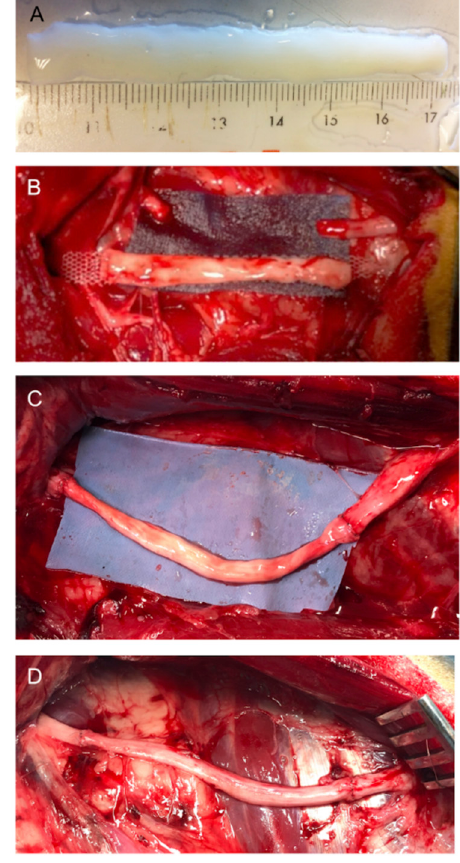
Figure 1. Decellularized nerve allograft ( A ) was trimmed into 7-cm nerve long and then it was placed into the gap created in the common peroneal nerve ( B ). The decellularized nerve allograft ( C ) or the same nerve segment resected used as autograft ( D ) were sutured bridging the gap.